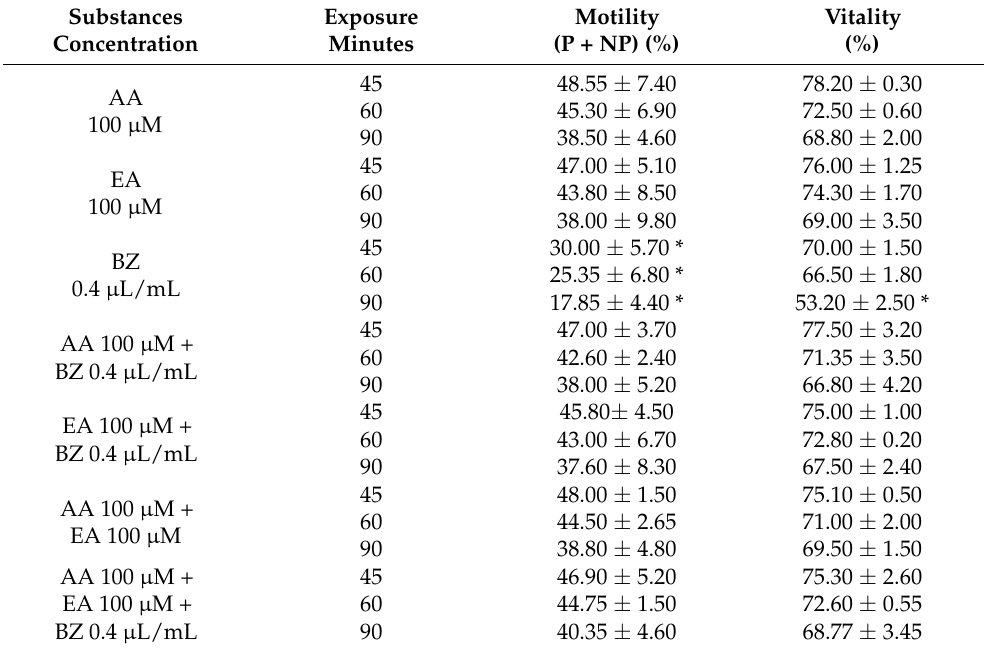
Table 2. Sperm motility (progressive, P, and non-progressive, NP) and sperm vitality after antioxidant and oxidant treatment. The values were expressed as mean ± SD and compared with the control group shown in Table 1. * p ≤ 0.05. AA: ascorbic acid; EA: ellagic acid; BZ: benzene.